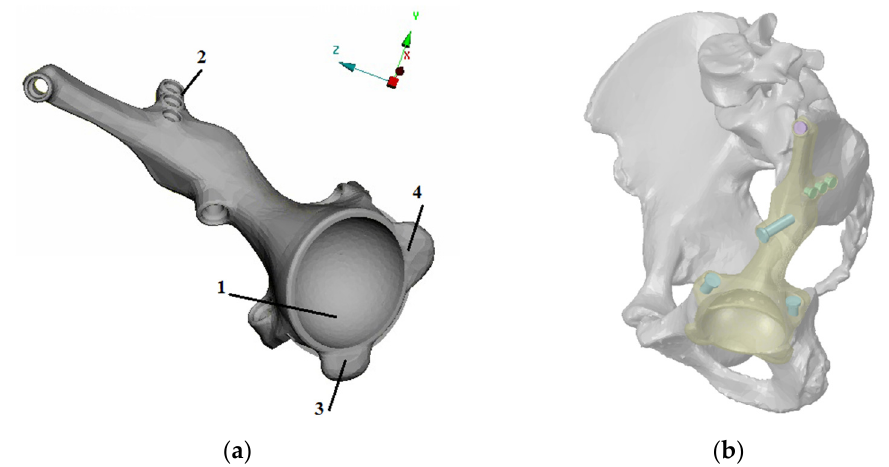
Figure 2. Developed design of the individual endoprosthesis considered in this paper: ( a ) design and main components of the implant: the cup (1), the bearing flange on the iliac bone (2), the bearing flange on the pubic bone (3), and the bearing flange on the ischiatic bone (4). ( b ) Implant position and fixation by seven screws.